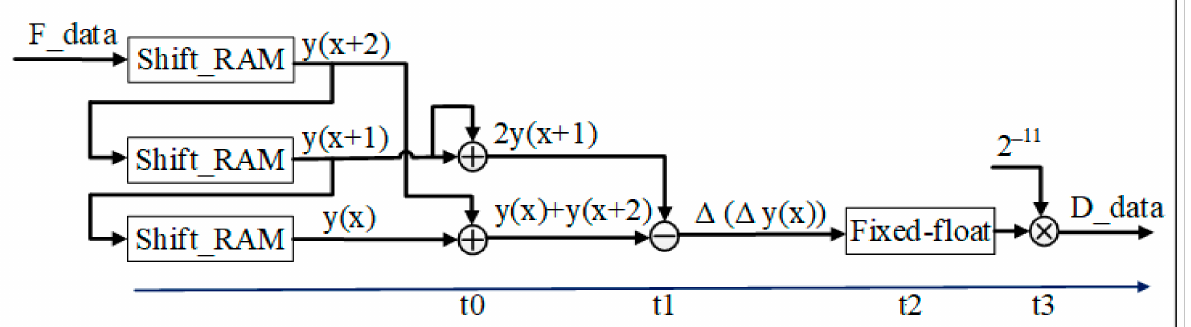
Figure 8. Second-order differential module.